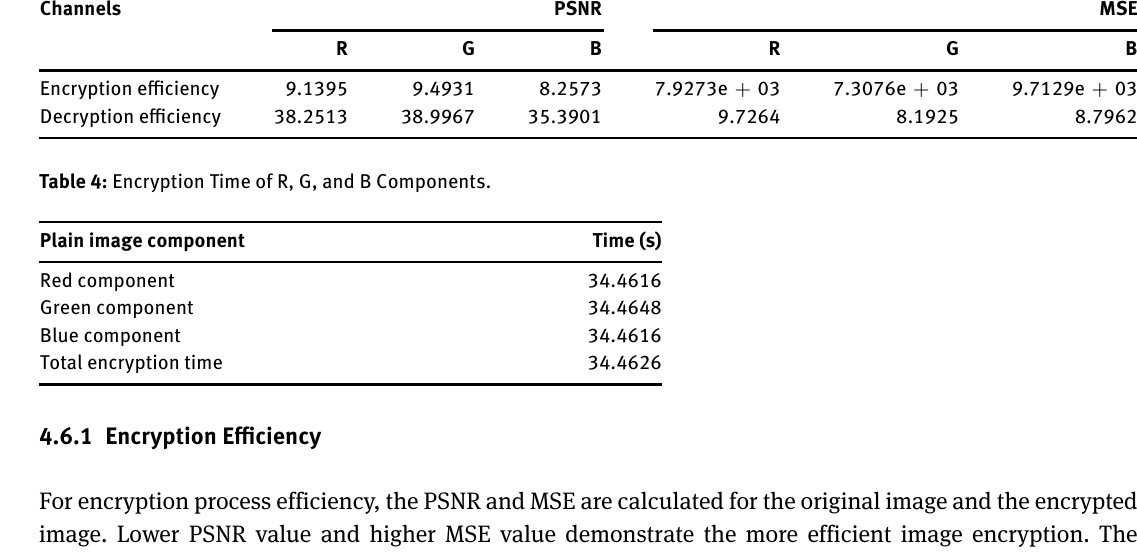
Table 3: Algorithm Eflciency Using PSNR and MSE Parameter for R, G, and B Channels.